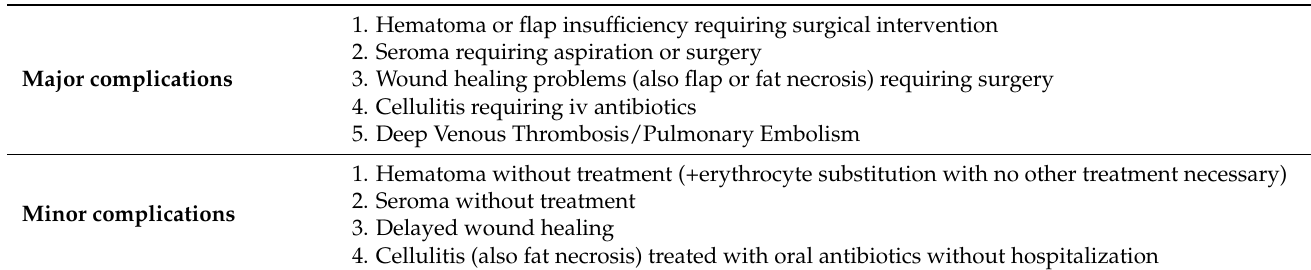
Table 1. Classification of Complications (modified from Neaman et al.